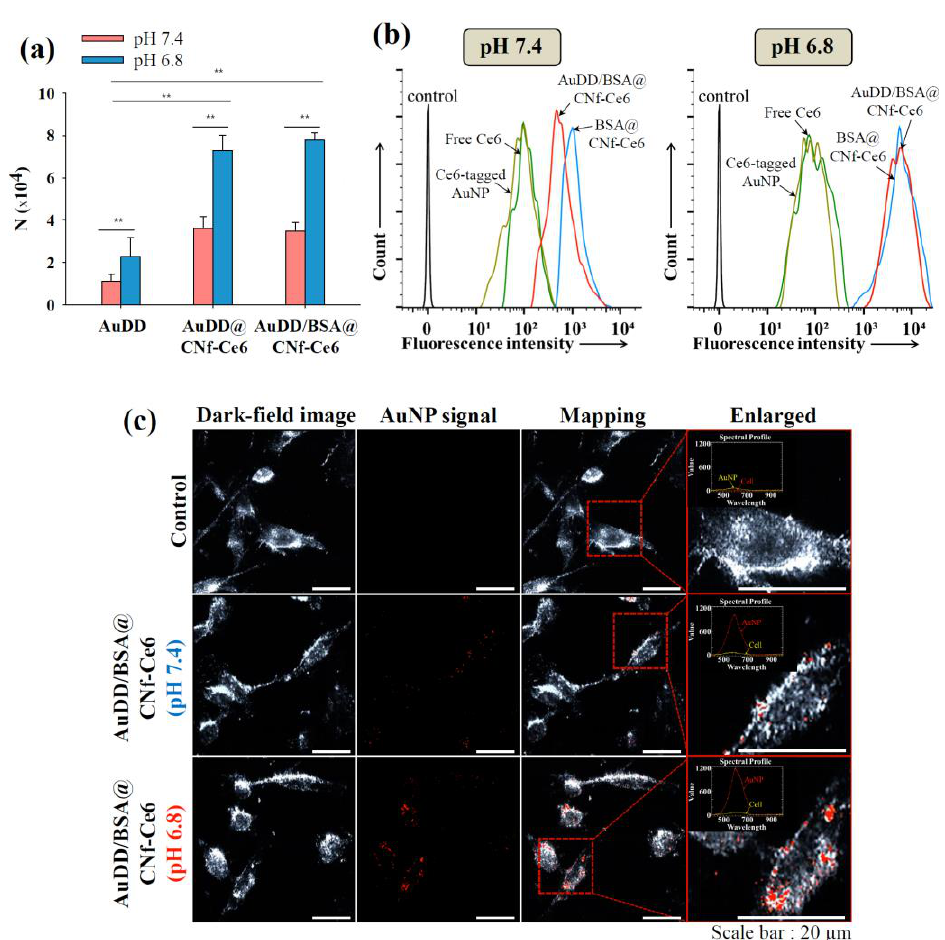
Figure 5. ( a ) Uptake value [number (N) of internalized AuDD particles per MDA-MB-231 cell for 8